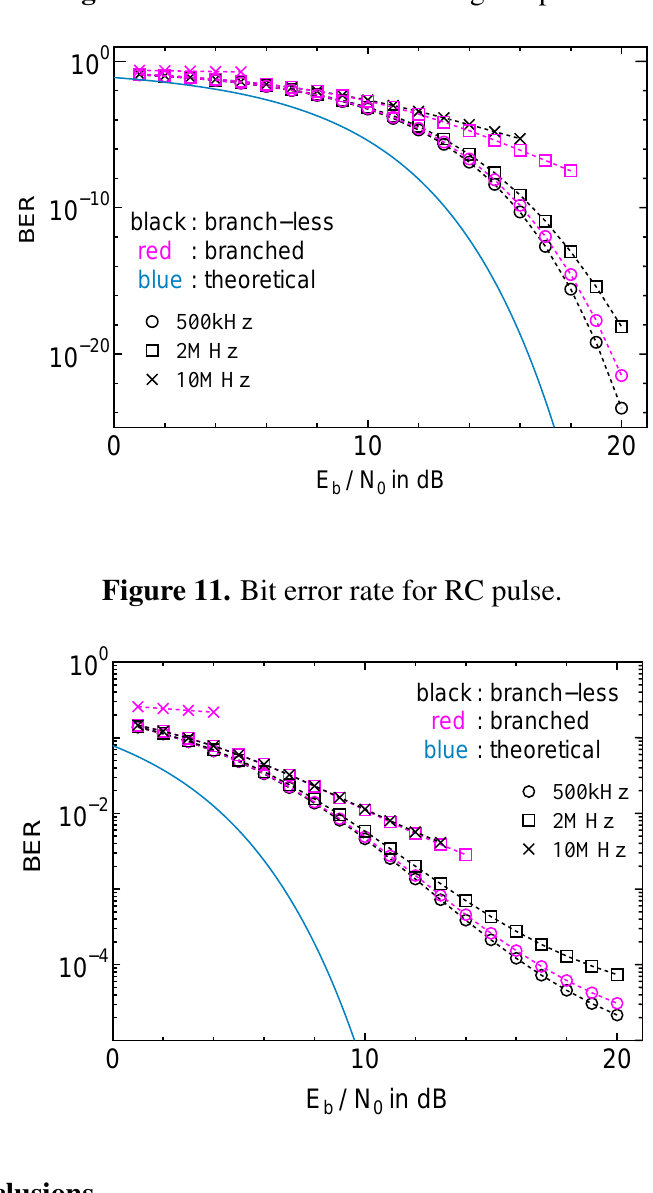
Figure 10. Bit error rate for rectangular pulse.